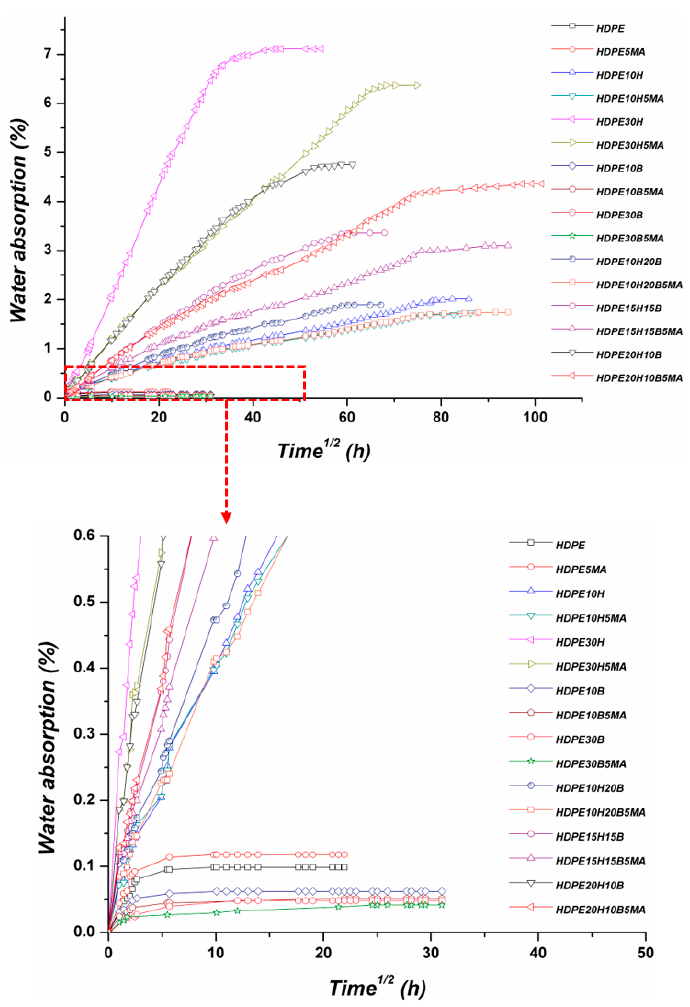
Figure 1. Water absorption curves of the di ff erent composites at room temperature.